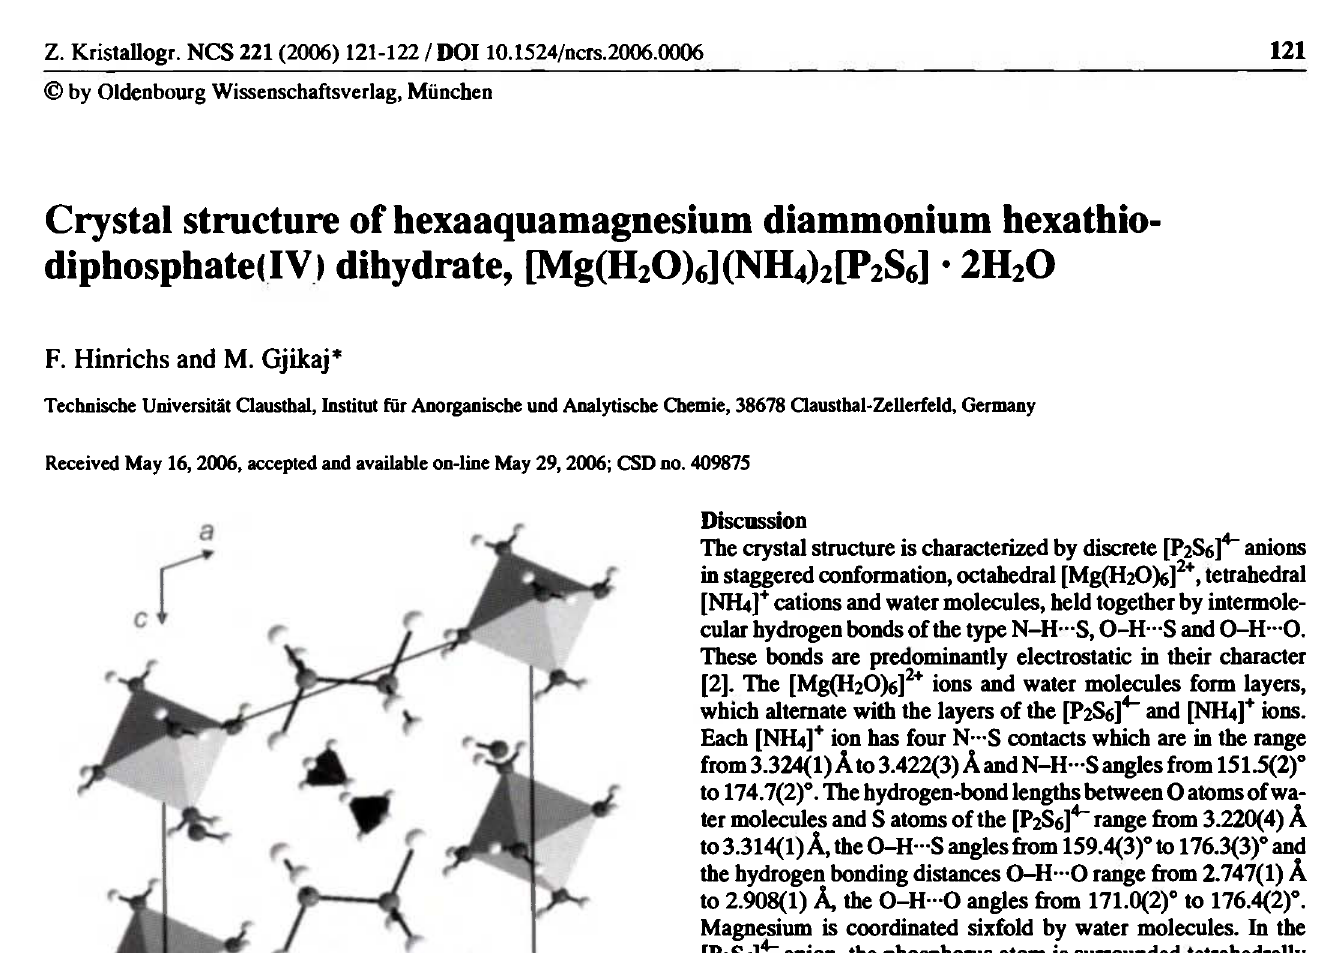
Table 1. Data collection and handling.